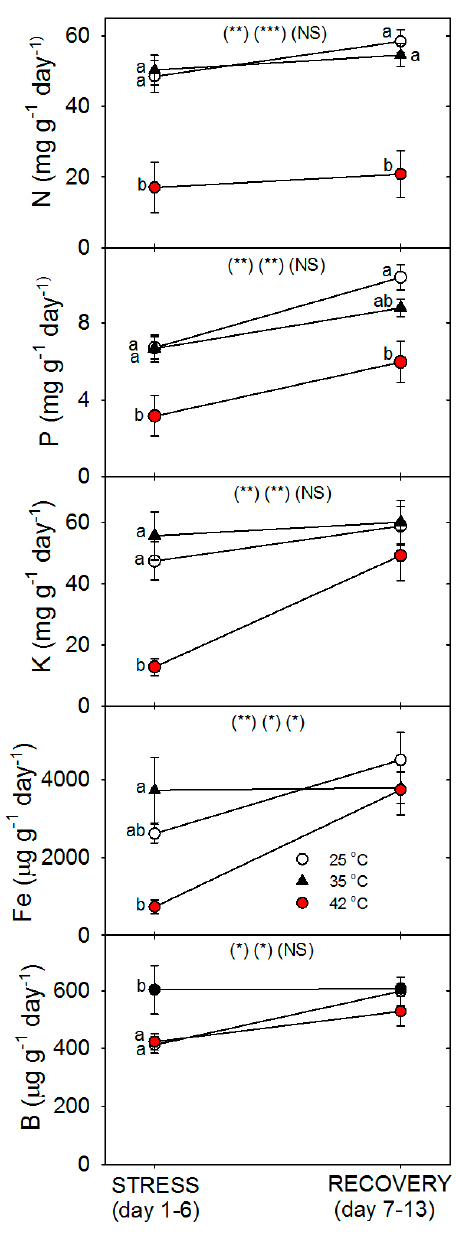
Figure 5. Effect of abrupt heat stress (days 1–6) and recovery (7–13) on the uptake rate of specific nutrients by roots of tomato (total mg for macronutrients and µg for micronutrients in the plant per g dry root per day). Plants were grown at 25 °C/20 °C day/night (control), and then subsets of plants were heat stressed at 35 °C/30 °C or 42 °C/37 °C day/night for one or six days (maximum root temperatures = 32 °C or 39 °C), and then returned to control conditions for seven days of recovery (=day 13). Values are means ± 1 SE for four independent replicates from each harvest (days 1, 6, 13). Statistics are as in Figure 1. * p < 0.05, ** p < 0.01, *** p < 0.001. Relative to control plants of the same age, heat stress (both 35 °C and 42 °C) initially decreased the concentration (per g dry root) of all the nutrient-uptake proteins we measured (NRT1, NRT2, AMT1, KT1, PHT1, FRO1, BOR1, and NIP5;1) (Figure 6, day 1). After six days of heat stress, the levels of nutrient uptake proteins in moderately-stressed plants were similar to unheated controls, but in severely-stressed plants, levels of these proteins remained below controls in all except for NIP5;1 and AMT1. After seven days of post-heat recovery, levels of these nutrient-uptake proteins had recovered